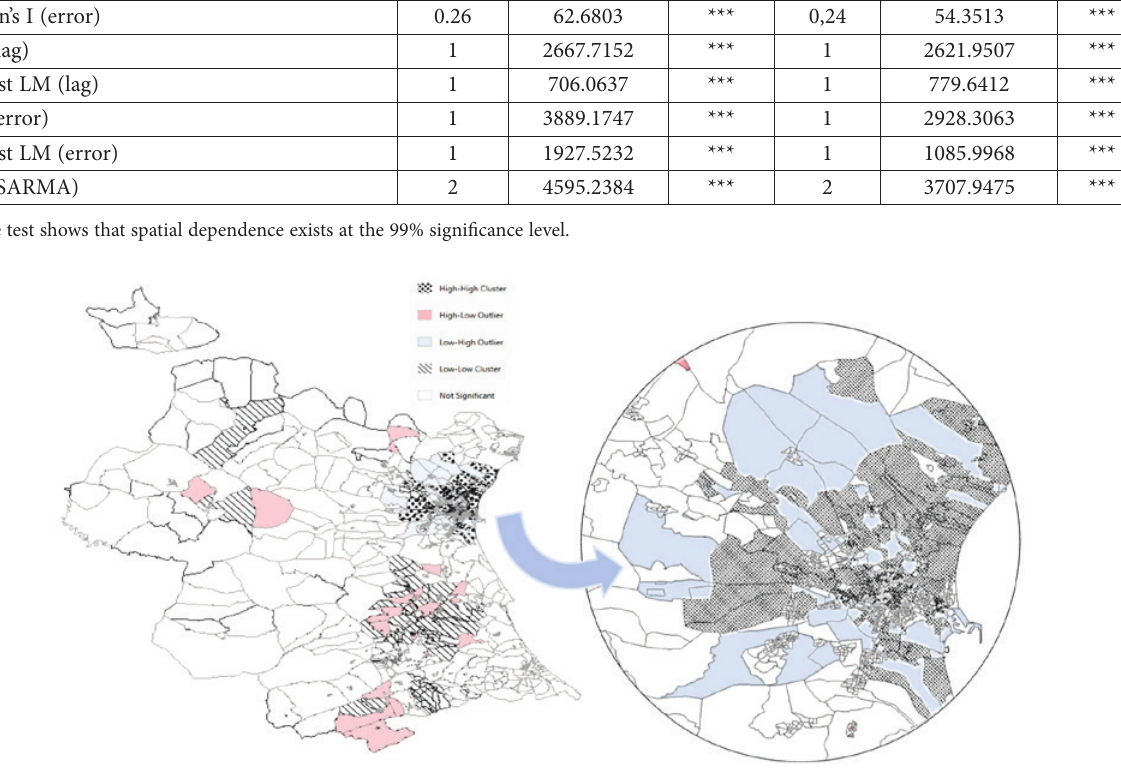
Figure 2. LISA (Local Indicators of Spatial Association) OLS Std_Residuals